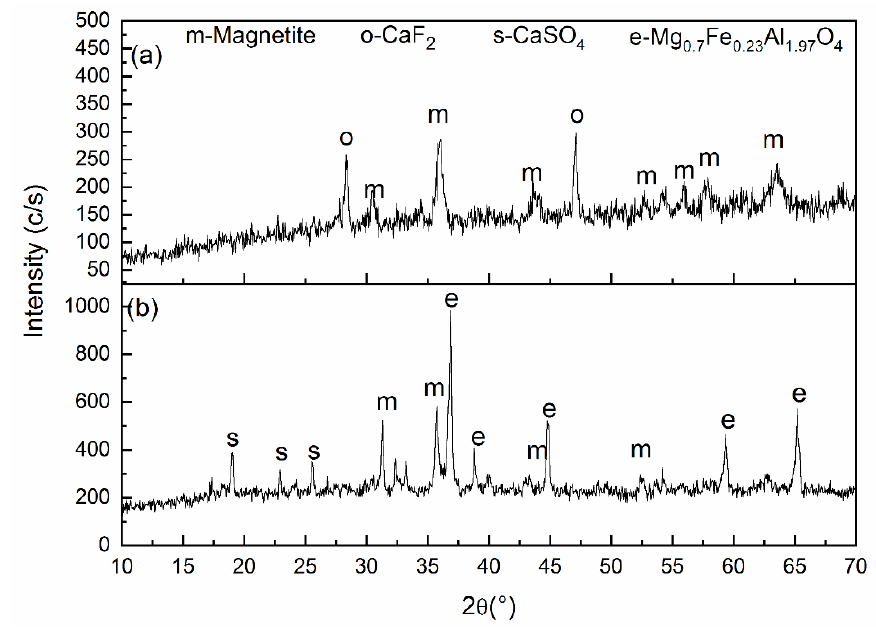
Figure 9. XRD of the residues at 123 ◦ C: ( a ) HF; ( b ) HF (15% v / v )-H 2 SO 4 (10% v / v ).